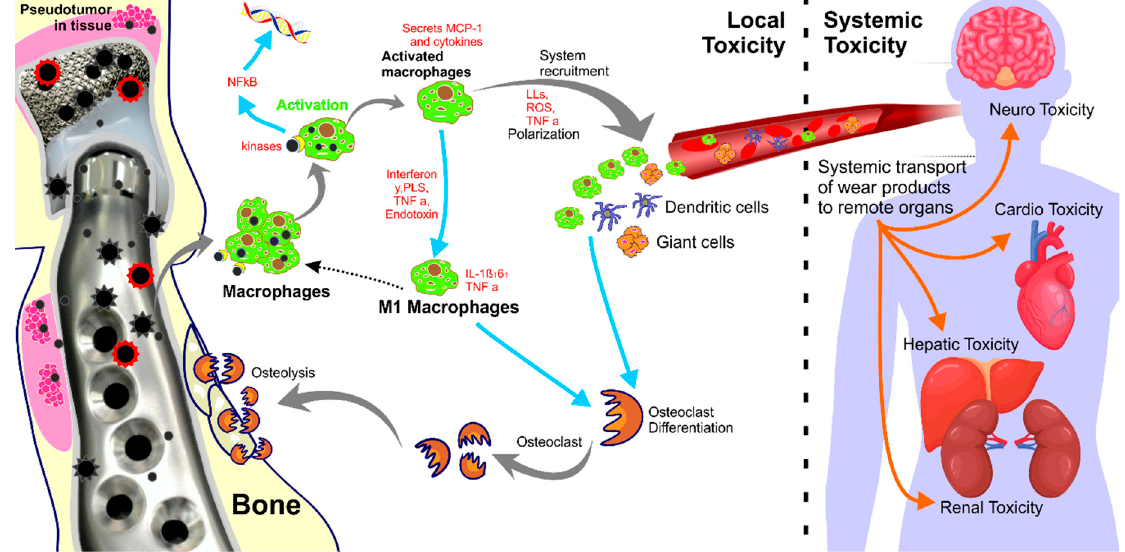
Figure 3. Schematics of the toxic effects of metallics debris released from the degradation of TMJ TJR prostheses.